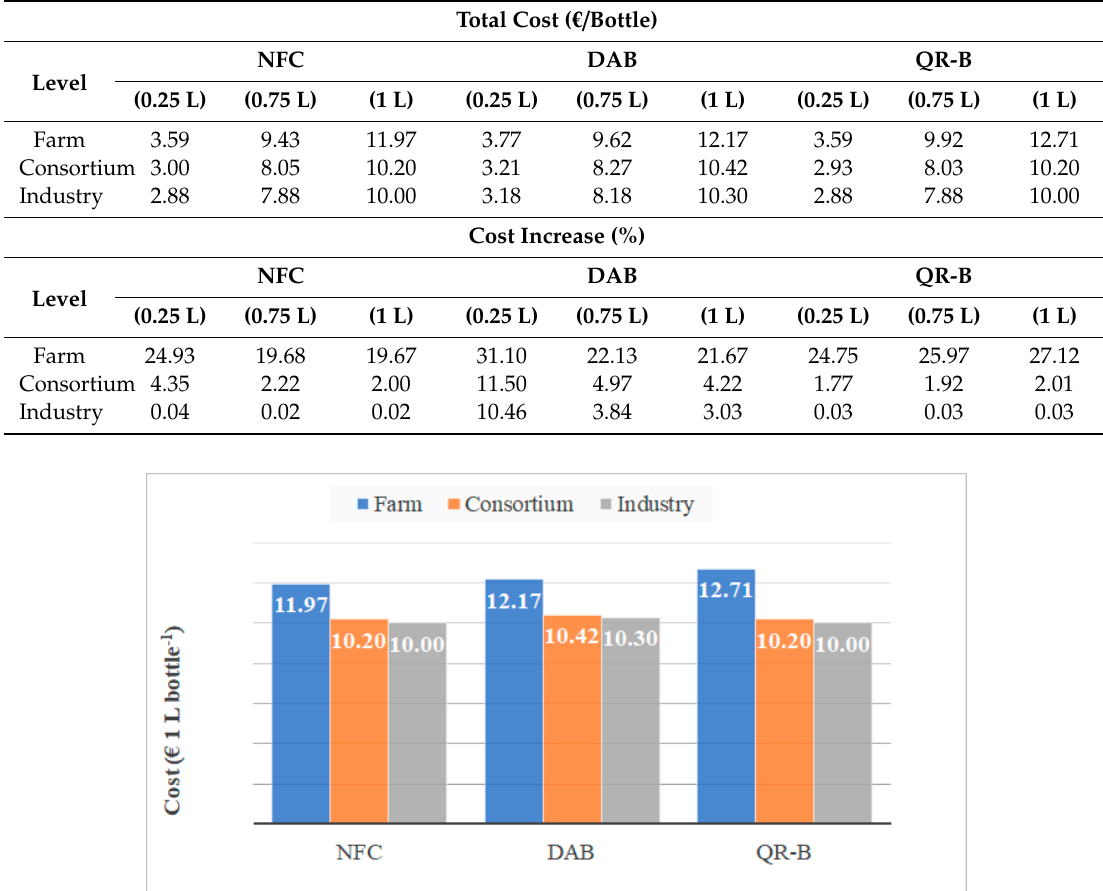
Table 8. Results of the economic analysis related to di ff erent scenarios examined.